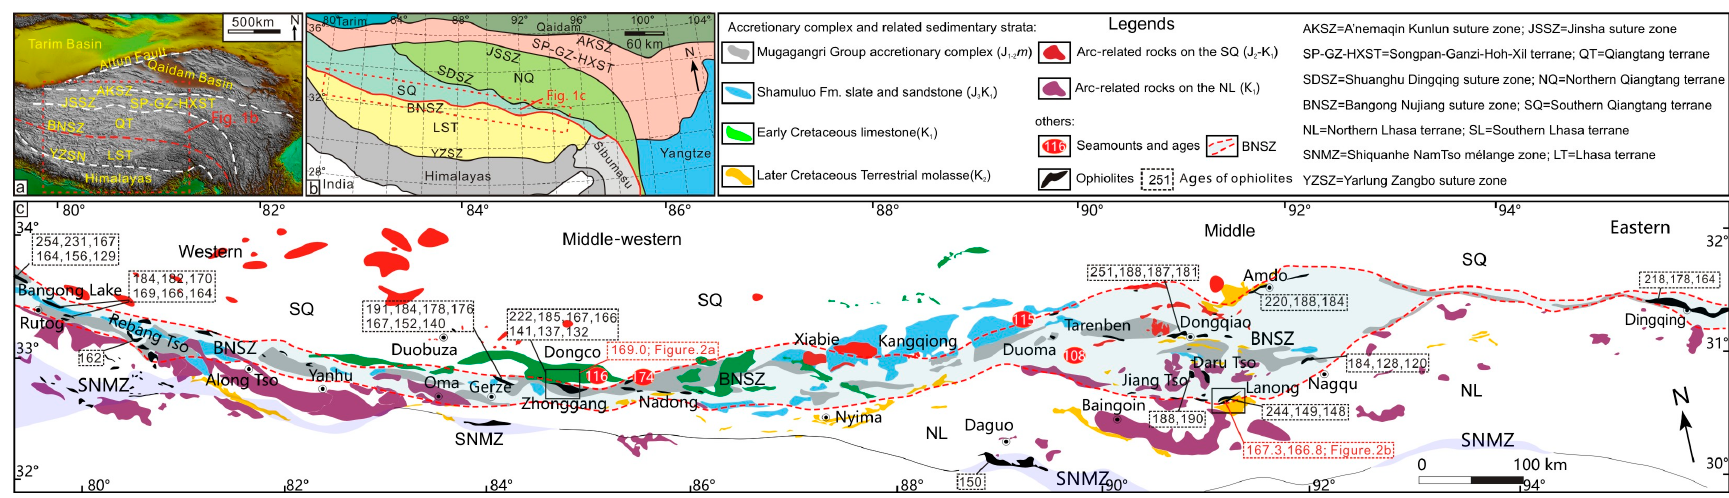
Figure 1. ( a ) Topography map of the Tibetan Plateau (digital elevation model data), showing major sutures by white dashed lines [17]. The Bangong-Nujiang Suture Zone (BNSZ) is shown by the red dashed line. ( b ) Tectonic outline of the Tibetan Plateau showing the location of the BNSZ (red line) [19]. ( c ) Generalized geological map of the BNSZ showing the occurrence of ophiolites [19,27,30]. The ages of the ophiolites, seamounts, and arc-related rocks are also shown. Compilation of data is from Table S1 in Supplementary Materials and references therein.